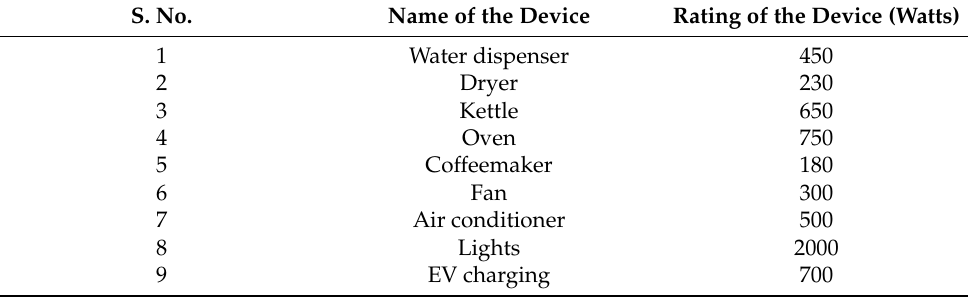
Table 3. Details of the commercial load.